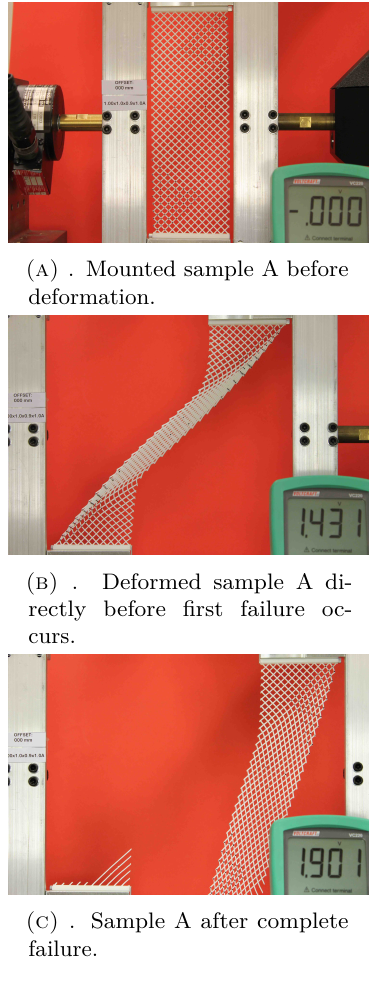
Figure 5. Shear deformation of sample A.